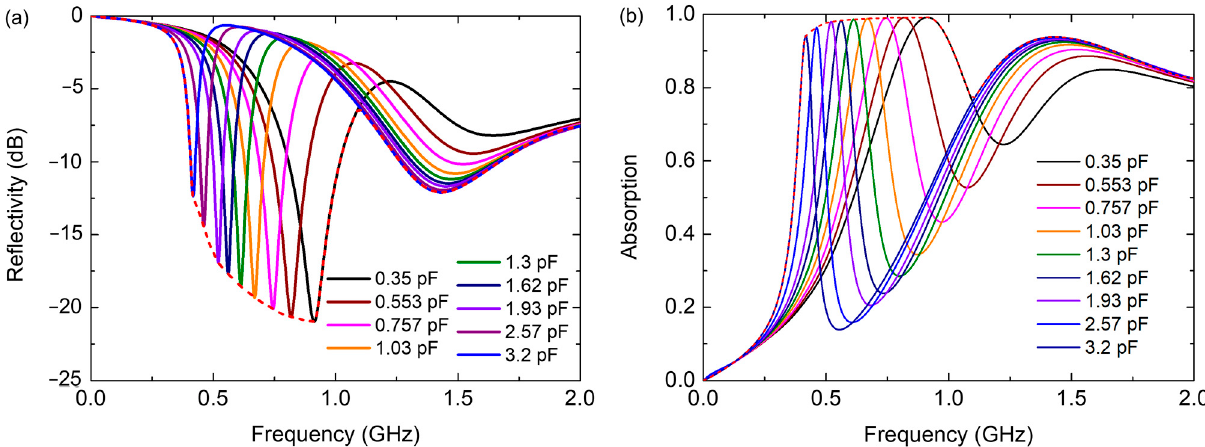
Figure 8. The simulated ( a ) reflection and ( b ) absorption curves by tuning the varactor capacitance. Dotted line shows the envelope of the achievable absorption region.